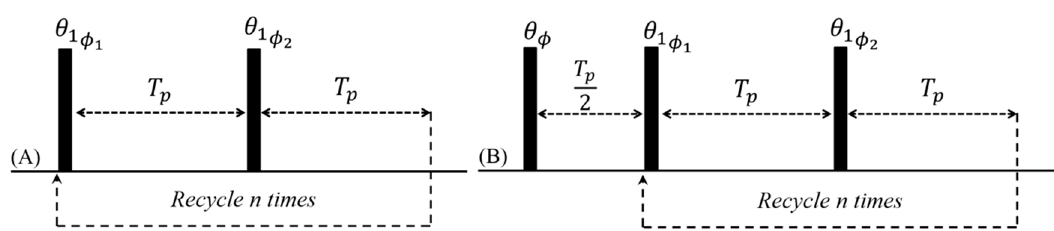
Figure 2. ( A ) Continuous Wave Free Precession (CWFP) and ( B ) Carr-Purcell Continuous Wave Free Precession (CP-CWFP) pulse sequences with phases ( φ ), flip angle ( θ = θ 1 = 90°) and time between pulses (T p ) shorter than the relaxation time T 2 * (T p < T 2 *). ( A ) φ 1 = φ 2 is the original CWFP sequence without phase alternation and φ 1 = −φ 2 is the 180° phase alternation (CWFPx-x). ( B ) φ = φ 1 = φ 2 is the original CP-CWFP pulse sequence and ( φ = φ 1 = −φ 2 ) is the 180° phase alternation CP-CWFPx-x. Adapted from Publication [24], Copyright (2015), with permission from Elsevier.